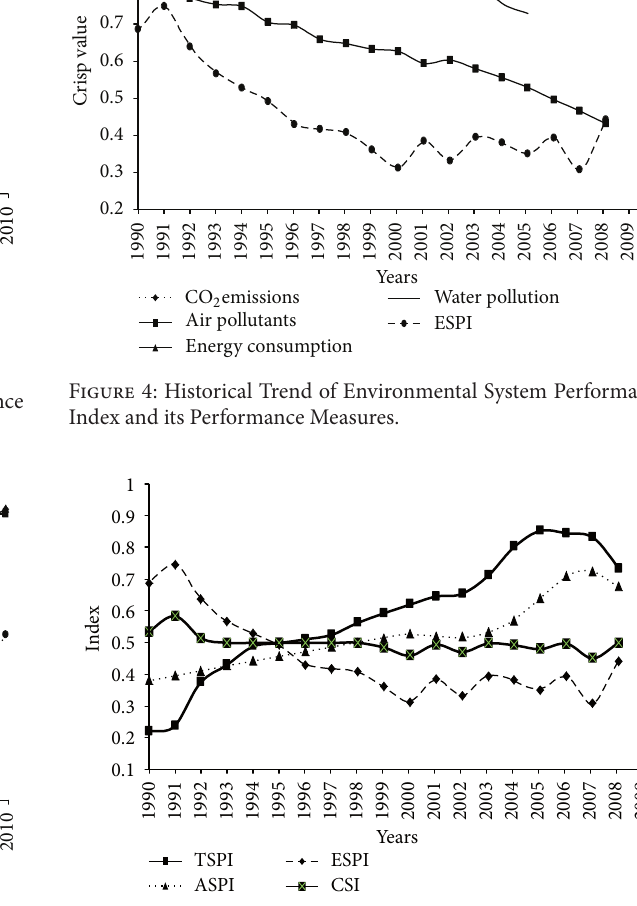
Figure 5: Historical Trend of Performance Indices and the Com- posite Sustainability Index for the Transportation, Activity, and Environmental